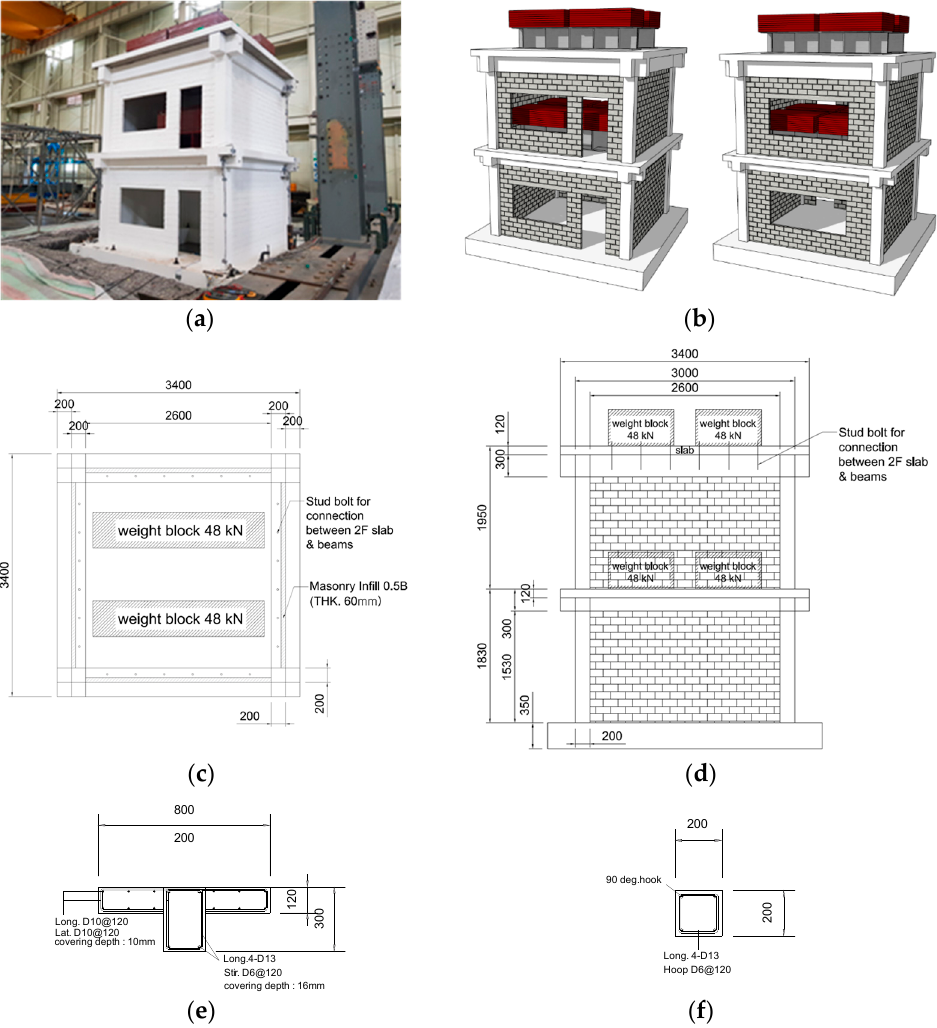
Figure 1. Configuration of specimen (unit: mm): ( a ) photo; ( b ) aerial view from the front (left) and the rear (right); ( c ) plan; ( d ) elevation; ( e ) beam and slab; ( f ) column. Table 1. Design of specimen.